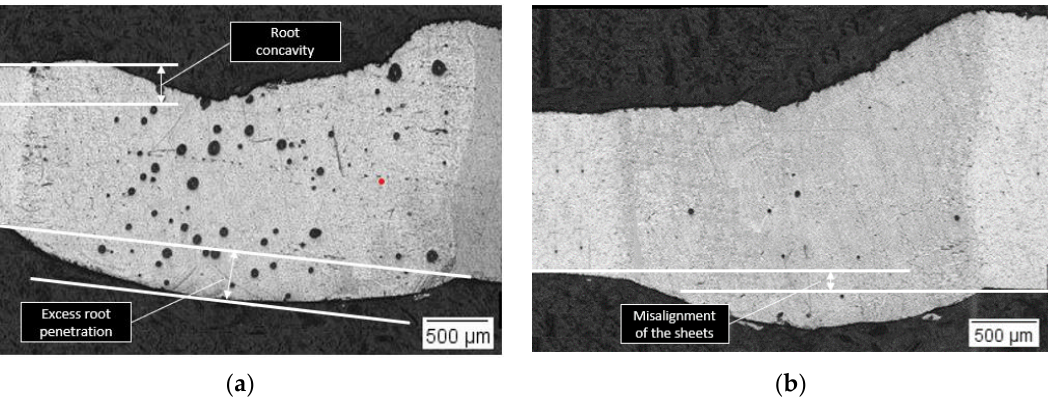
Figure 4. Welded joint imperfections according to the ISO 13919-2 standard: ( a ) root concavity and excess root penetration; ( b ) misalignment of the sheets.